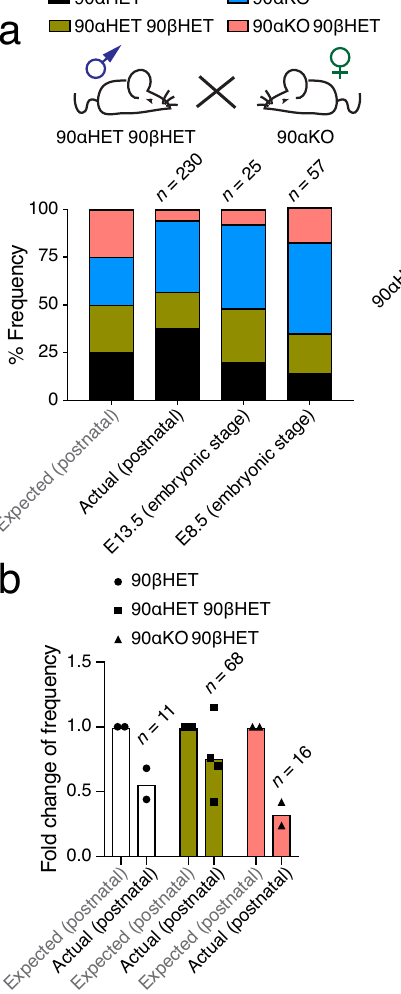
offspring of the indicated genotype with the number n standing for the total number of pups with that genotype. c Morphology of newborn pups at postnatal day 1 (P1) from crossing 90 α HET 90 β HET and 90 α KO mice. The 90 α KO 90 β HET pup isstillbornand developmentally retarded in thisset. d Expectedand observed genotype frequencies in live pups (postnatal) from backcrossing 90 α HET 90 β HET male and 90 α KO 90 β HET female. Only female 90 α KO 90 β HET mice were used in this breeding strategy. n indicates the total number of analyzed pups or embryos. Source data are provided as a Source Data fi